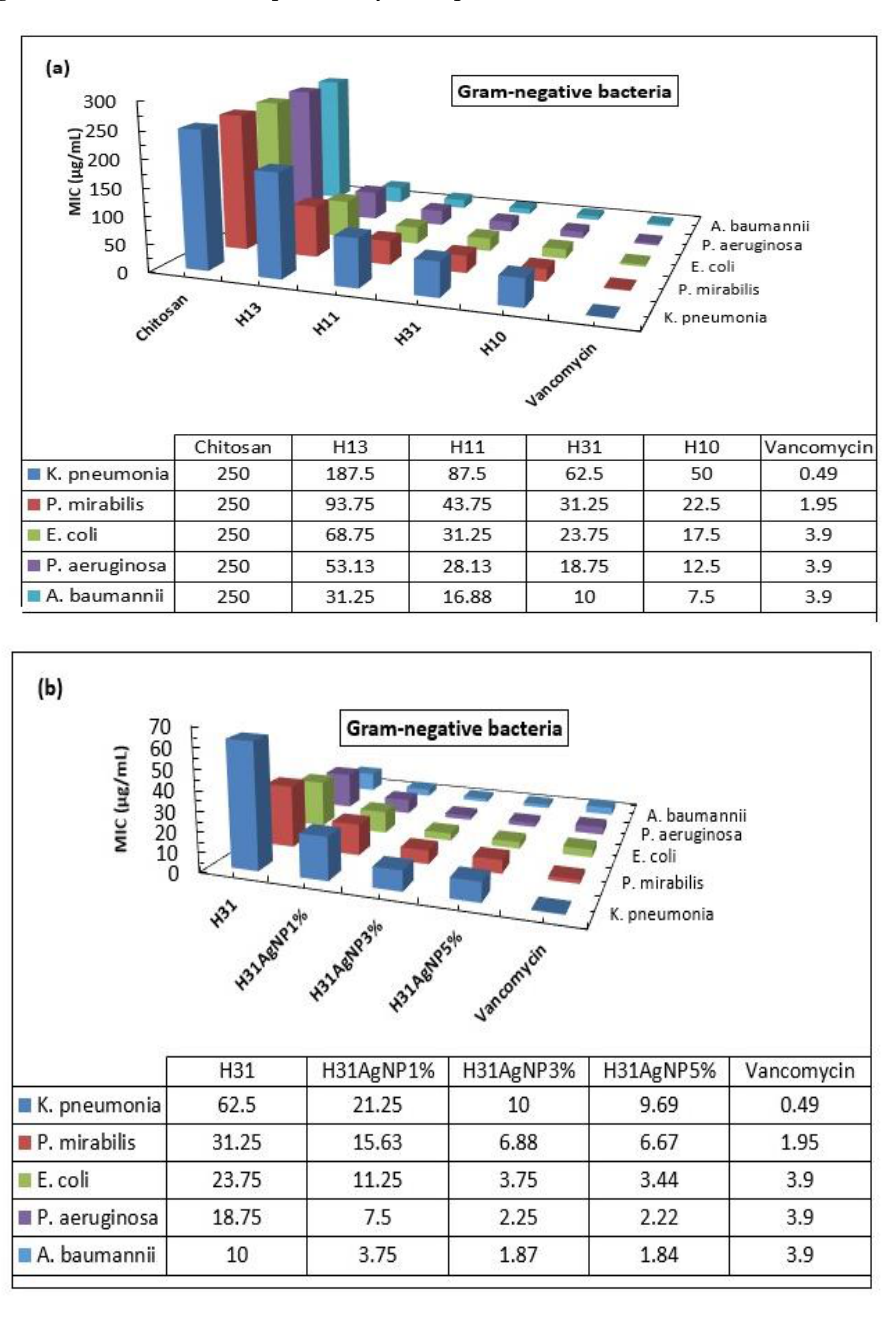
Figure 9. MIC values of: ( a ) hydrogels and ( b ) H 31 /AgNP composites against the tested Gram- negative bacteria.